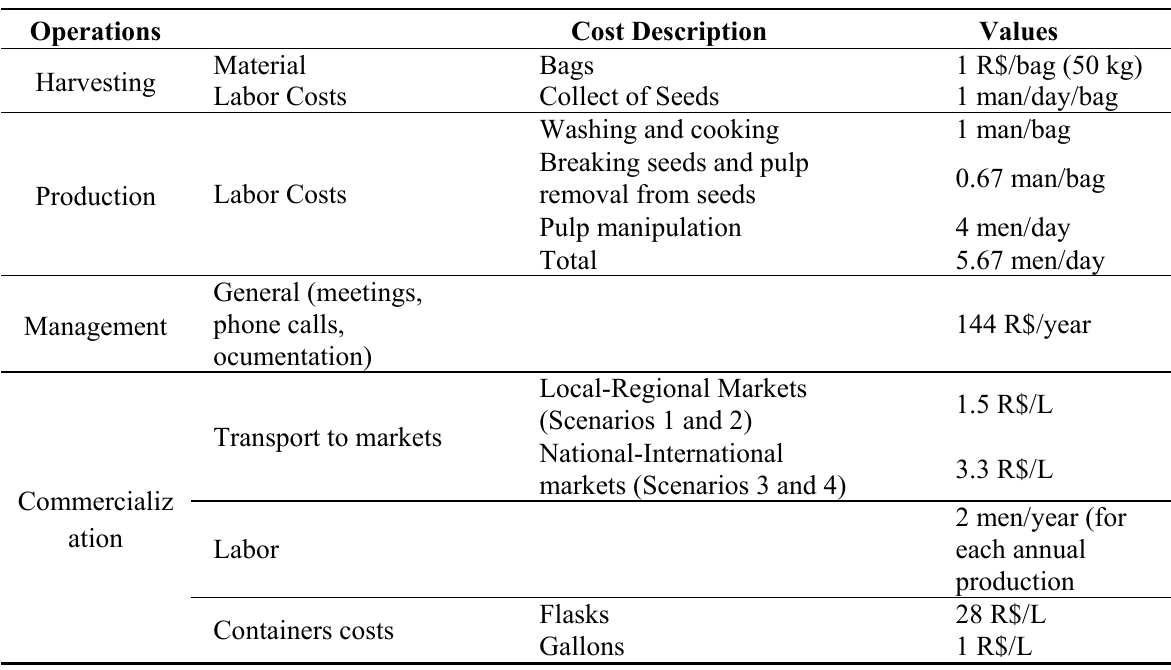
Table 2. Parameters used to assess the cost and the benefits of andiroba oil